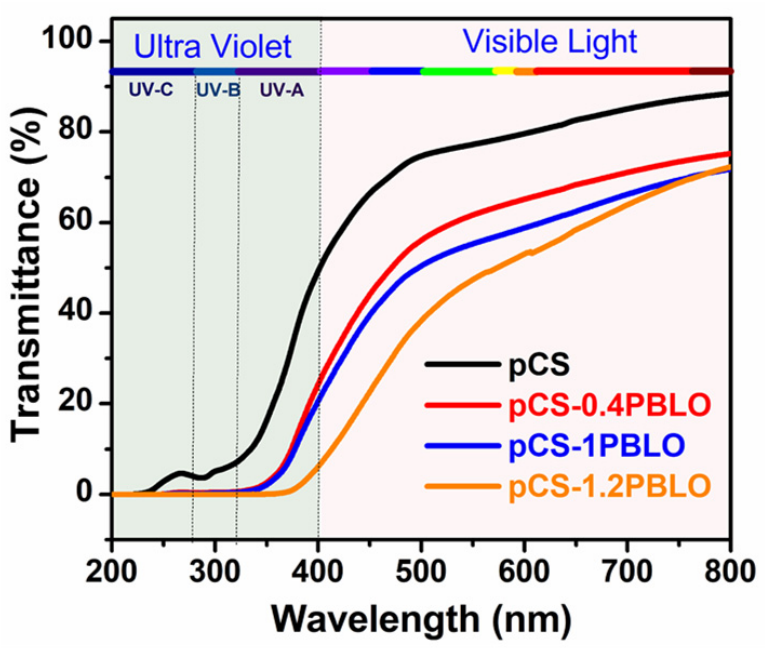
Figure 5. UV-Vis analyses of the pCS, pCS-0.4PBLO, pCS-1PBLO, and pCS-1.2PBLO.